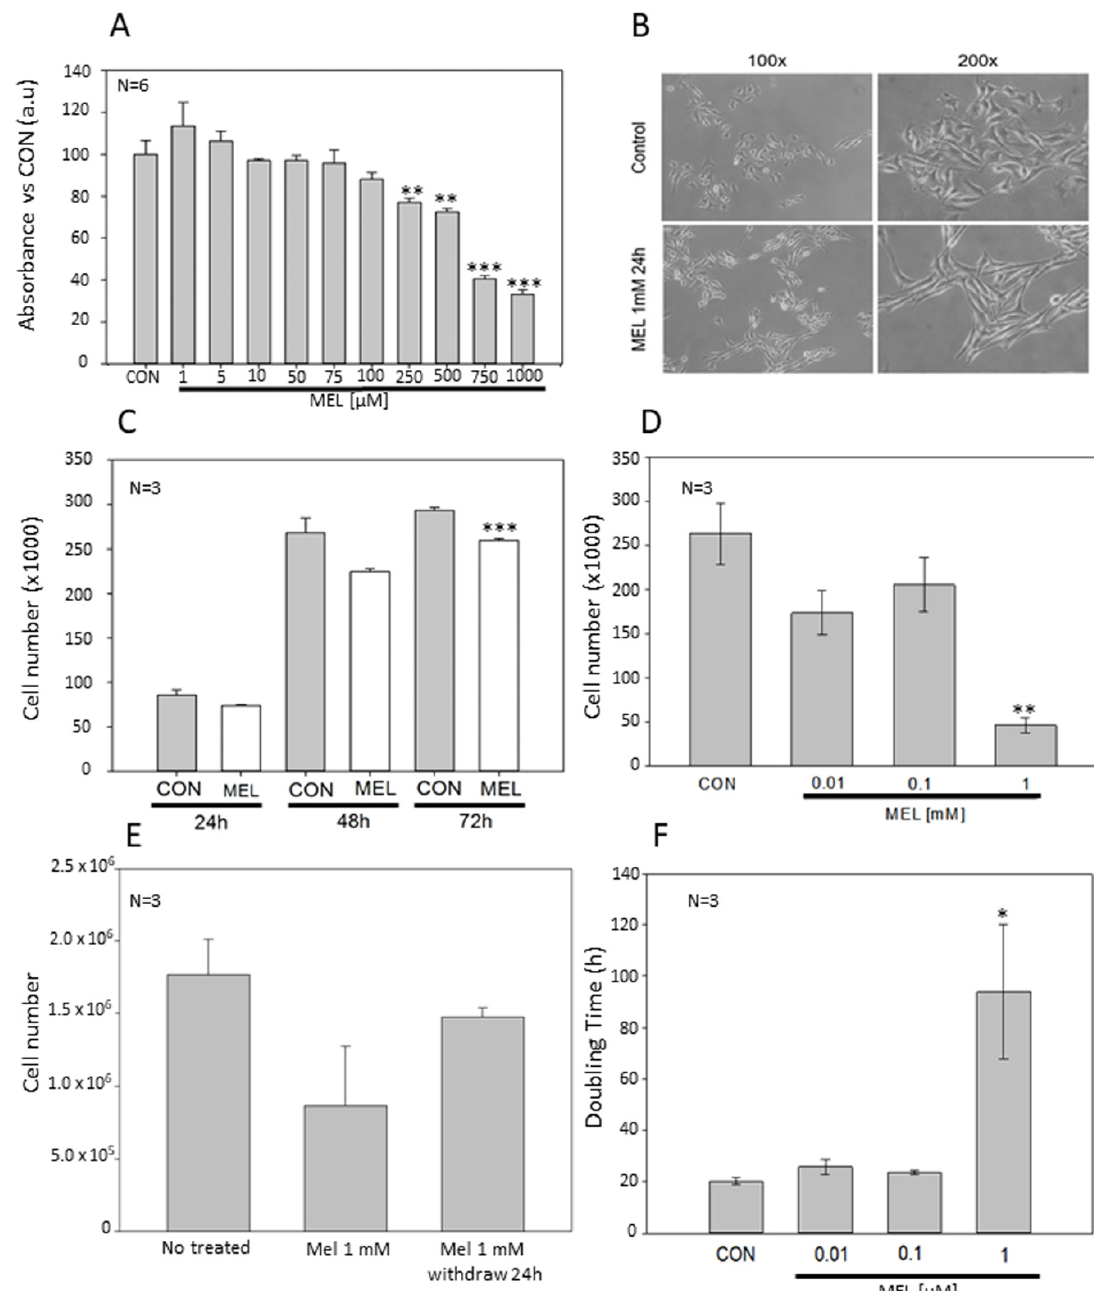
Figure 1. Antiproliferative e ff ect of Melatonin in B16-F10 melanoma cells. ( A ) MTT cell viability assay. Cells were seeded in 96 Wells plate at the indicated concentrations, after 72 h MTT reduction levels were assessed. ( B ) B16-F10 micrographs from control or melatonin-incubated cells were taken at a final magnification of 100 × and 200 × . ( C ) Average cell number after 24, 48, and 72 h of treatment with 0.1 mM of melatonin. ( D ) Average cell number after 72 h of treatment with di ff erent concentrations of melatonin. ( E ) Average cell number after 24 h of treatment with 1mM of Melatonin and withdraw treatment other 24 h. ( F ) Cell culture doubling time of every experimental group after treatment with melatonin during 72 h. Data were shown as average +/ − SEM. Significance vs. CON. * p < 0.05, ** p < 0.01, *** p < 0.001